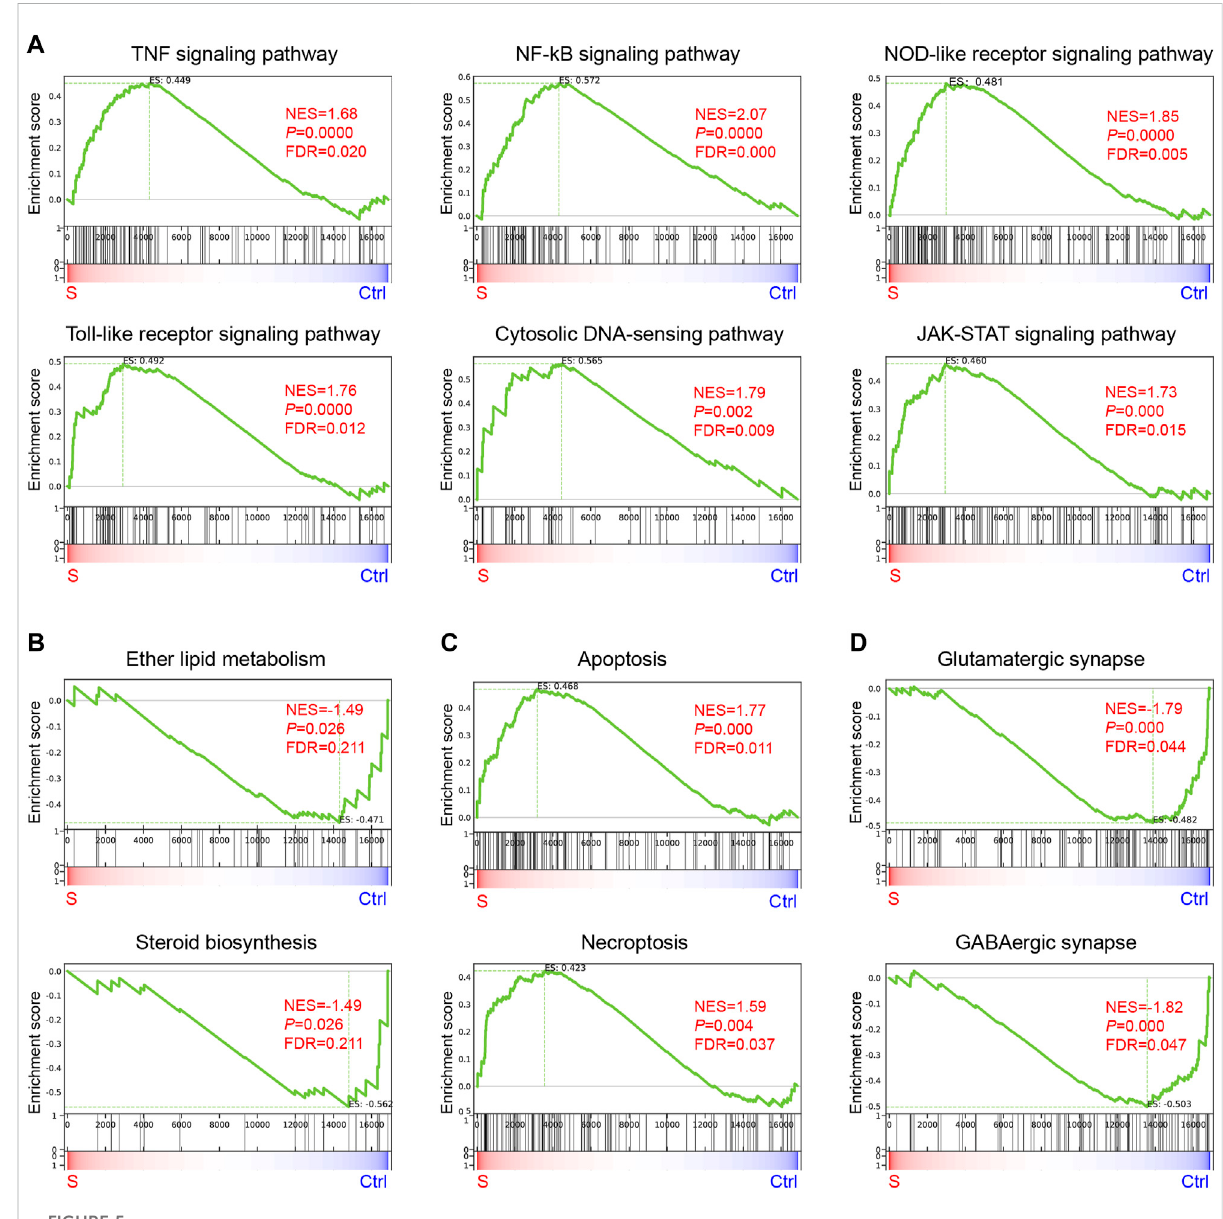
FIGURE 5 GeneenrichmentanalysisofgenesenrichedinthehippocampusduringtheprogressionofSAE. (A – D) KEGGTermsrelatedtoin fl ammation (A) , lipid metabolism (B), apoptosis and necroptosis (C) , and synapse (D)